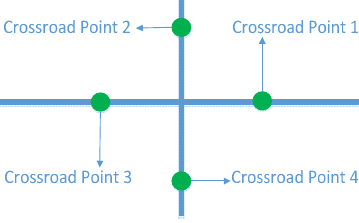
Figure 5. The special points (junction) are placed nearby in the crossroad.